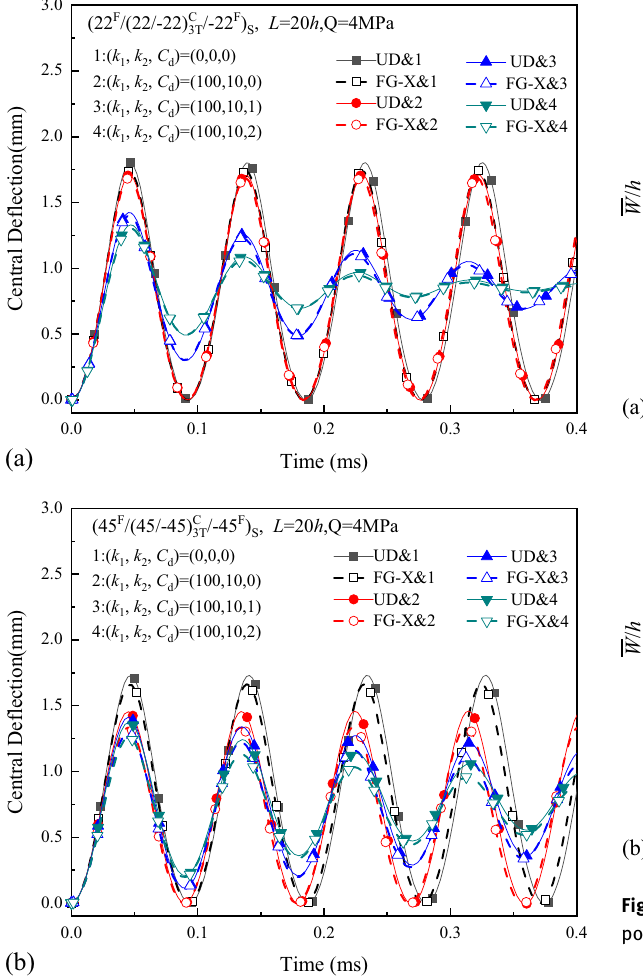
Figure 14: E ff ect of foundation coe ffi cients on forced vibration of hybrid plates.